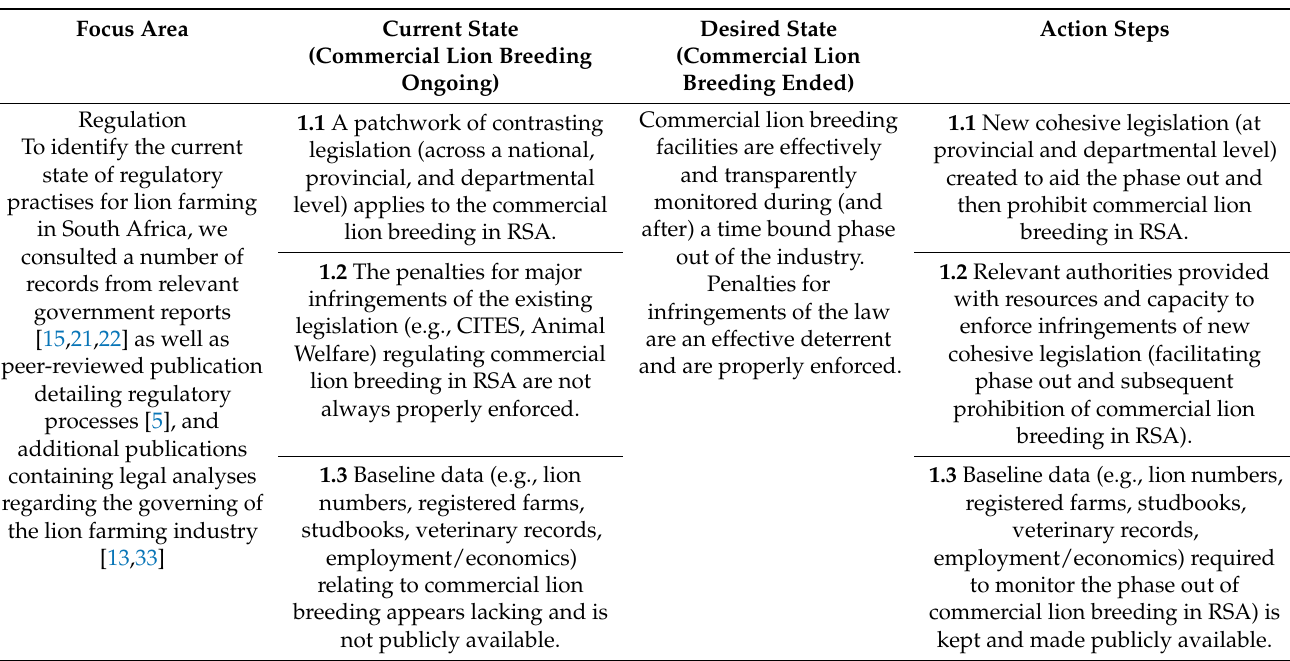
Table A1. Detailed summary of results Table